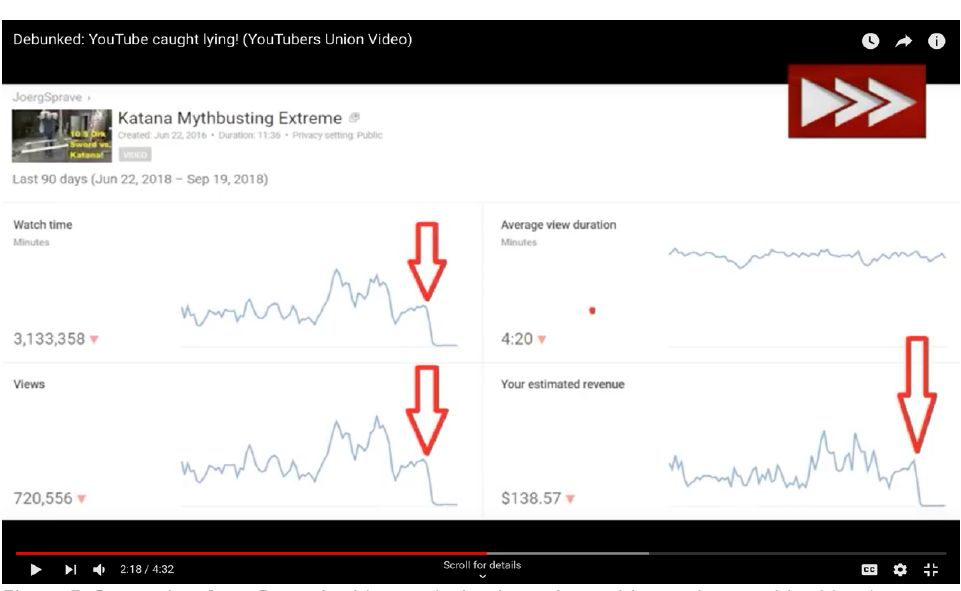
Figure 3: Screenshot from Sprave’s video analysing how viewership numbers on his video (two graphs on the left) dropped at the same time his video was demonetised (bottom right